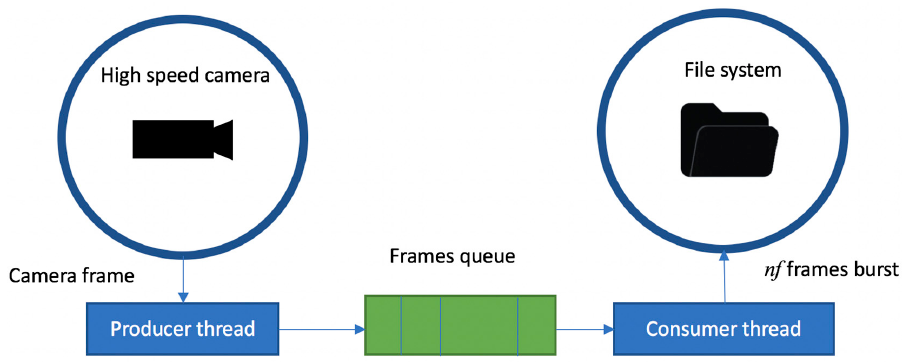
Figure 3. High-speed video capturing and storing process.